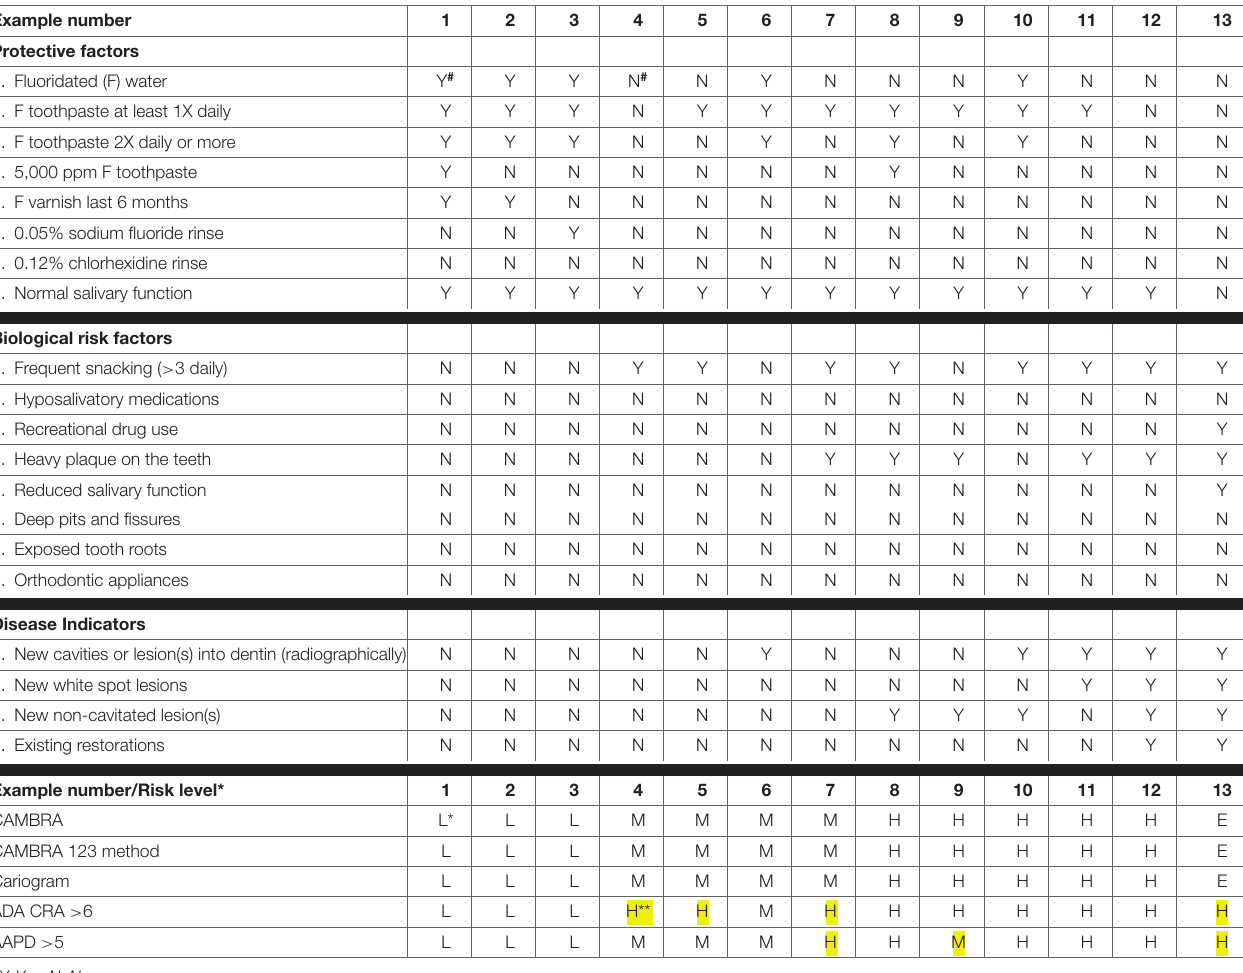
TABLE 5 | Comparison of Ages 6 year through adult CAMBRA, Cariogram, ADA and AAPD CRA forms using hypothetical patient example cases. Example